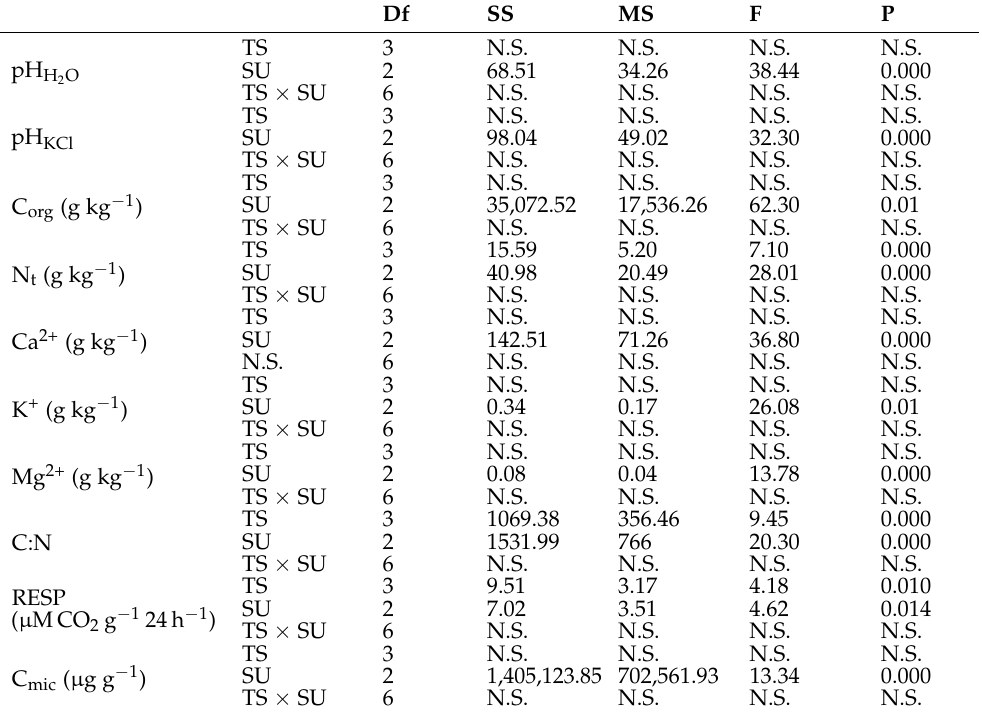
Table 3. Two-way ANOVA results for tree species (TS) and substrate (SU) effect on soil chemical properties and microbial activities: N.S.—not significant, C org —organic carbon, N t —total nitrogen, Ca 2+ —calcium, K + —exchangeable potassium, Mg 2+ —exchangeable magnesium, C:N—C to N ratio, RESP—basal respiration rate, and C mic —microbial biomass carbon.